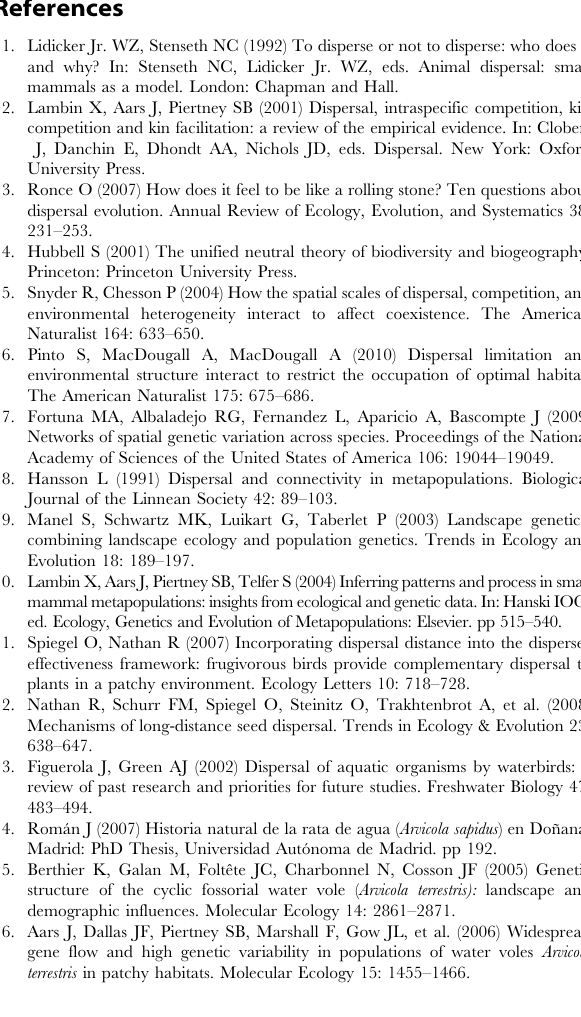
Table S1 Linearized pairwise F ST distances between populations estimated with microsatellite data (all p , 0.05, upper diagonal) and geographic distance (meters, lower diagonal).